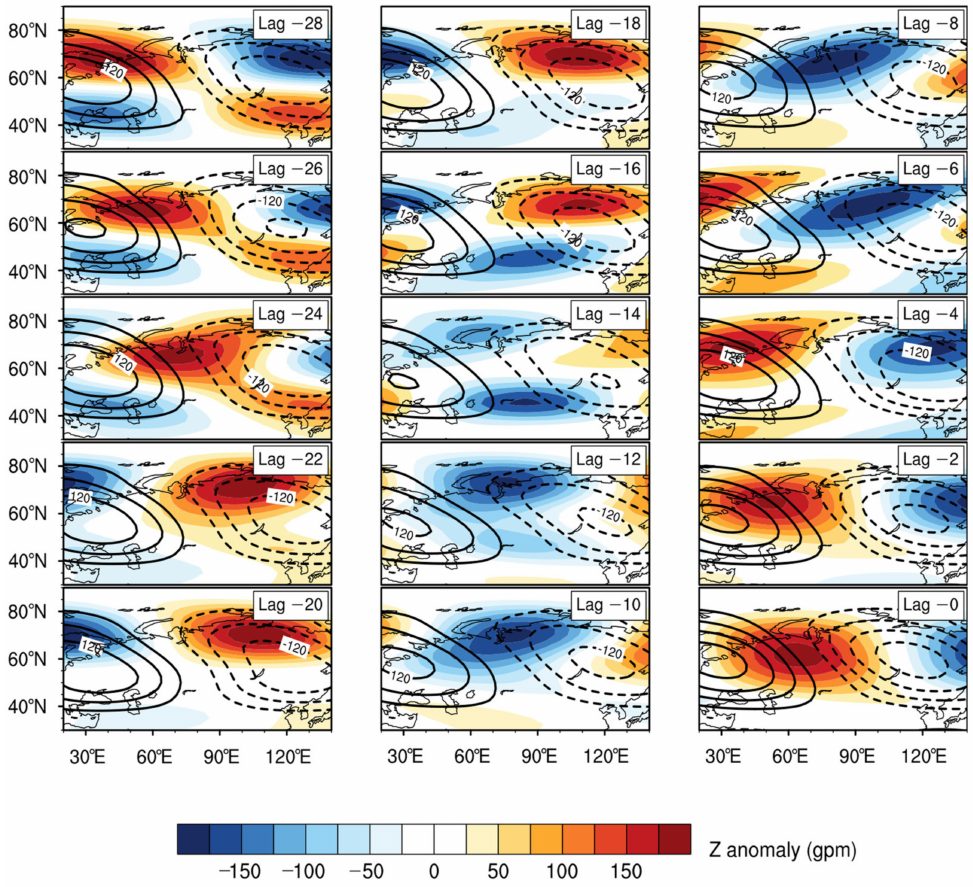
Figure 10. The development of 10–60-day filtered wave 2 geopotential height anomalies (shadings; unit: gpm) and the corresponding climatological geopotential height (black lines; unit: gpm) at 250 hPa from 14 days before the onset of the 2018 SSW to the onset day. Contour interval for the geopotential height anomalies is 40